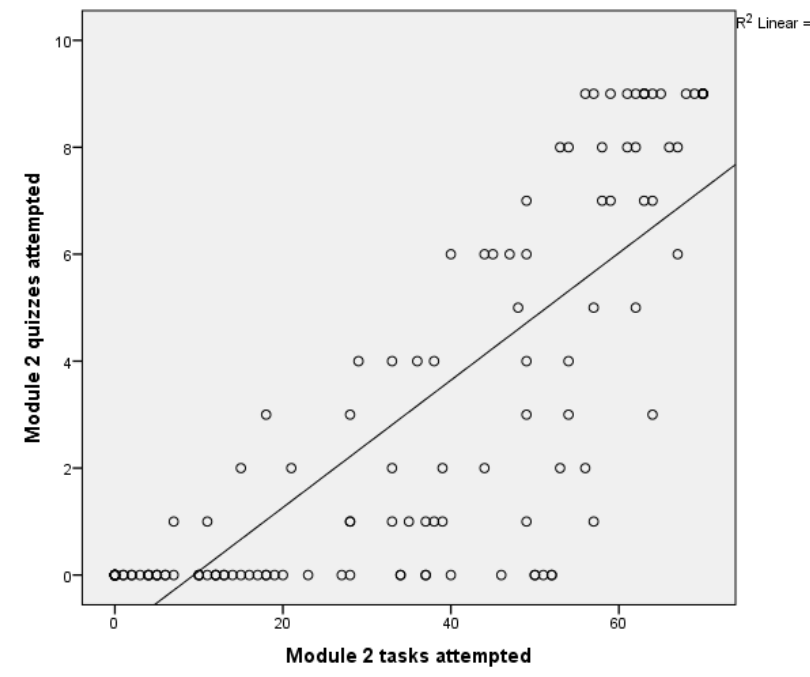
Figure 8: Scatterplot of correlation between task and quiz completion, Module